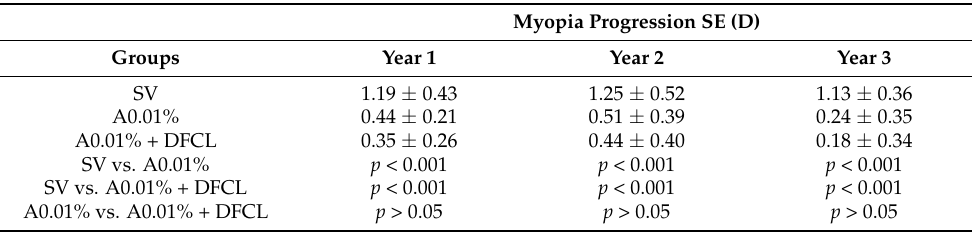
Table 2. Myopia progression during three years of the study SE: spherical equivalent, SV: single-vision spectacle lenses. A0.01: 0.01% atropine for two years of treatment. A0.01% + DFCL: